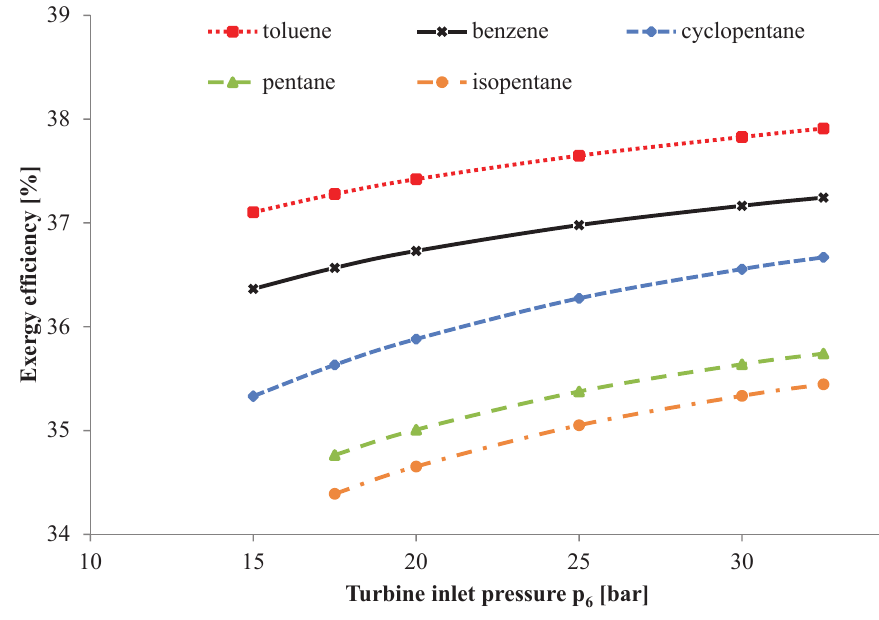
Figure 4. Exergy efficiency of the plant as a function of the pressure p turbine serving the organic Rankine engine. The curves are for each working fluid